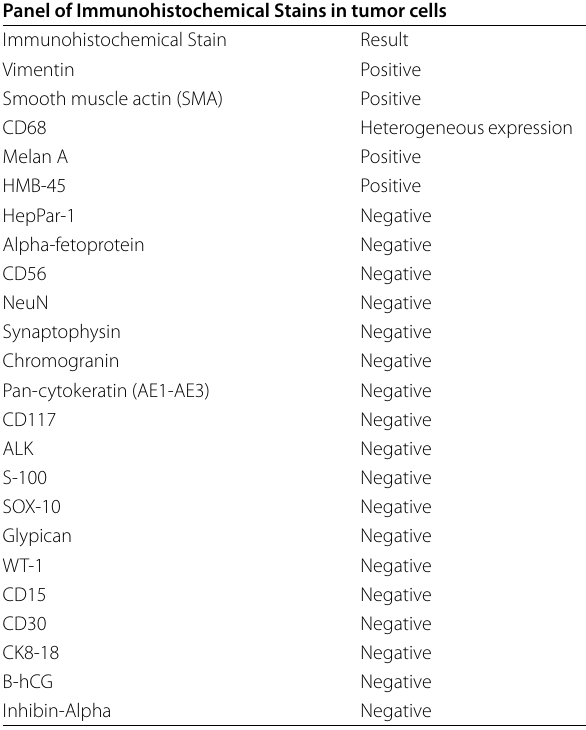
Table 1 Summary of immunohistochemical studies Panel of Immunohistochemical Stains in tumor cells Immunohistochemical